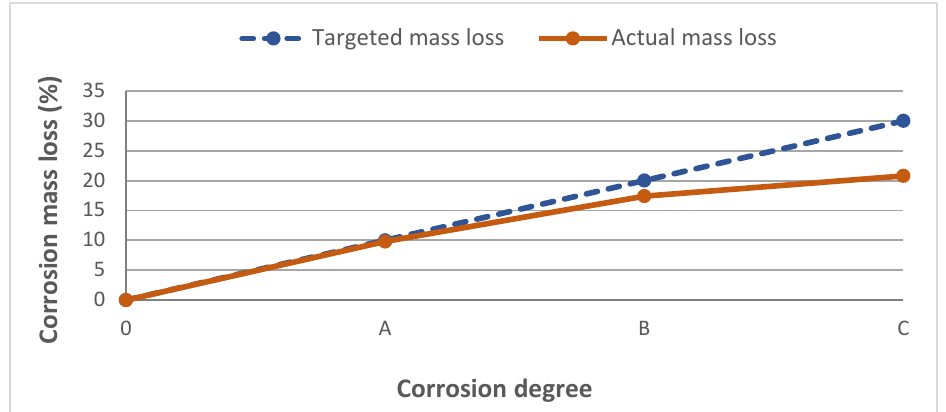
Figure 10. Variation between targeted and actual mass losses.